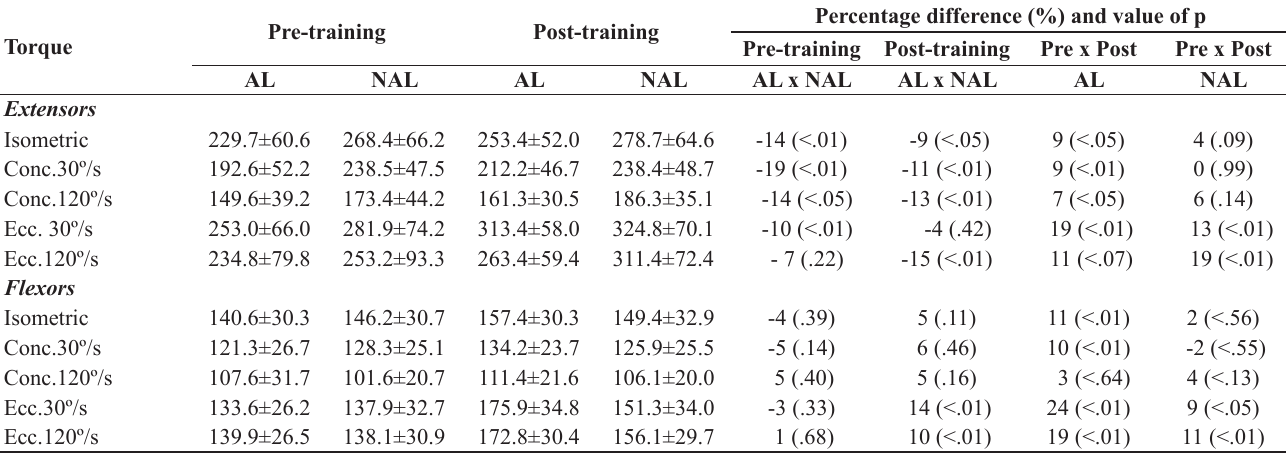
Note: Student t -test (paired = pre and post; independent = AL x